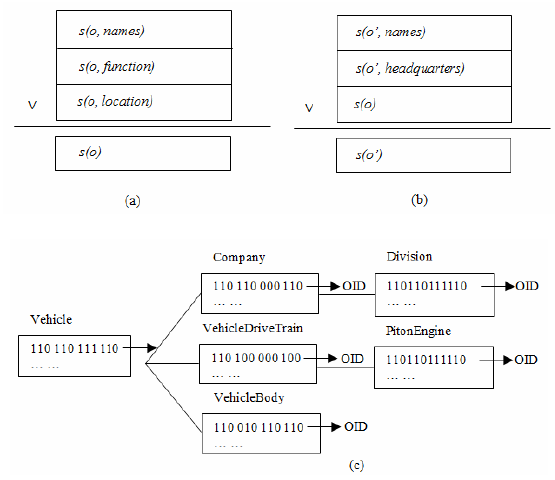
Figure 2. Signature and signature file hierarchy